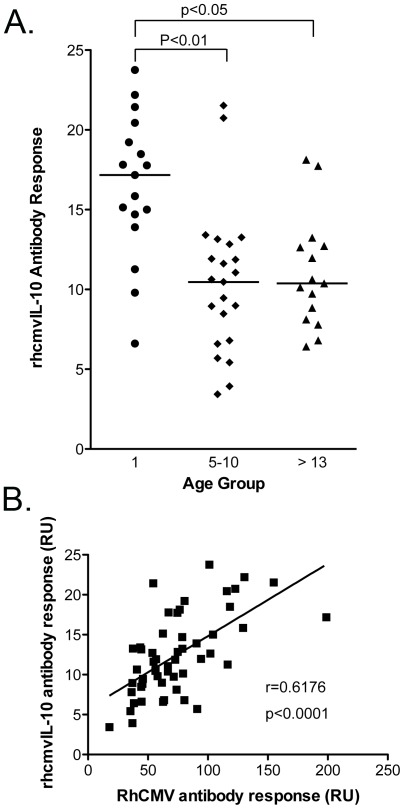
rhcmvIL-10 antibody response.(A) An age comparison of rhcmvIL-10 responses in 54 macaques seropositive for RhCMV stratified into 3 age groups; infant (≤1 year), adult (5–10 years) and aged (≥13 years). The infants had significantly higher antibody titers than the adults and aged (p<0.01, p<0.05 respectively). Statistical analysis between age groups was done using Kruskal-Wallis test with Dunn's Multiple Comparison. There was no significant difference between the adult and aged animal groups. (B) Linear regression analysis of RhCMV antibodies and rhcmvIL-10 antibodies from 53 rhesus macaques reported in relative units (RU). There was a significant correlation between total RhCMV titers and rhcmvIL-10 antibody titers (Pearson r = 0.6176, p<0.0001) with RhCMV antibody titers being significantly predictive of rhcmvIL-10 antibody production.